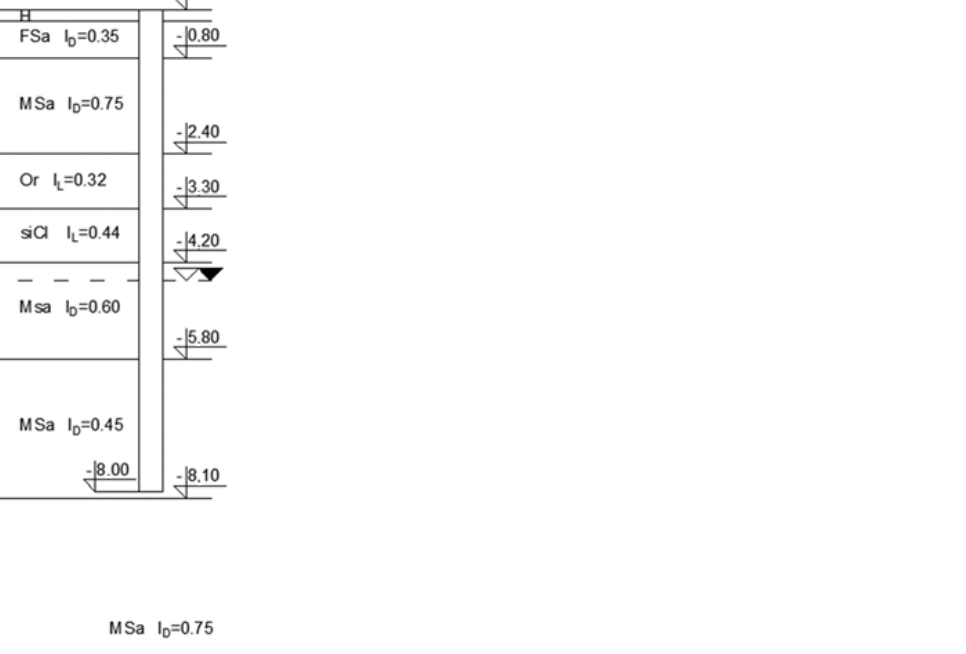
Figure 1. Geotechnical profile at the location of an 8 m steel closed-end pipe-pile under testing. Table 1. Basic geotechnical Table 1. Basic geotechnical parameters.